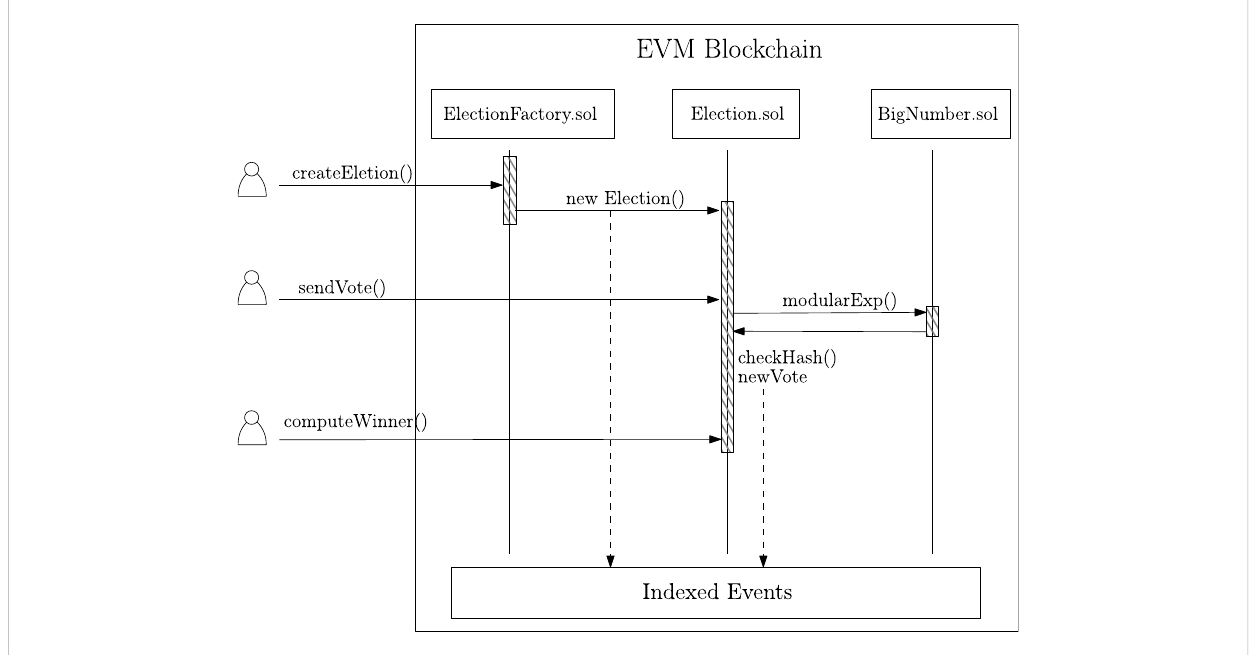
FIGURE 1 Scheme representing the interaction between the user and the smart